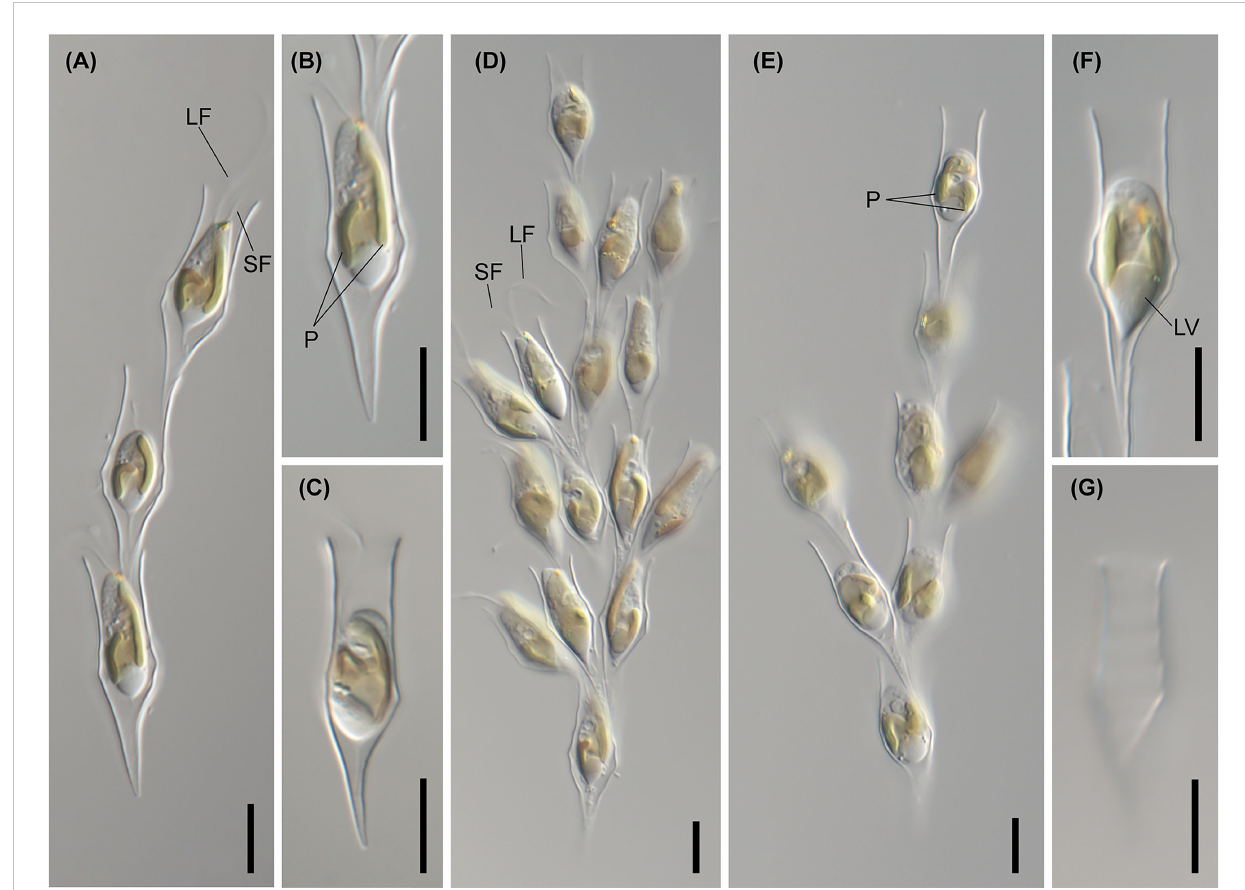
FIGURE 5 Light micrographs of Dinobryon species. (A, B) Images of D. divergens CCMP2900. (C) Image of D. divergens CCMP3056. (D – G) Images of D. divergens Deokghi051818A. LF, long fl agellum; LV, leucosin vesicle; P, plastid; SF, short fl agellum. Scale bars = 10